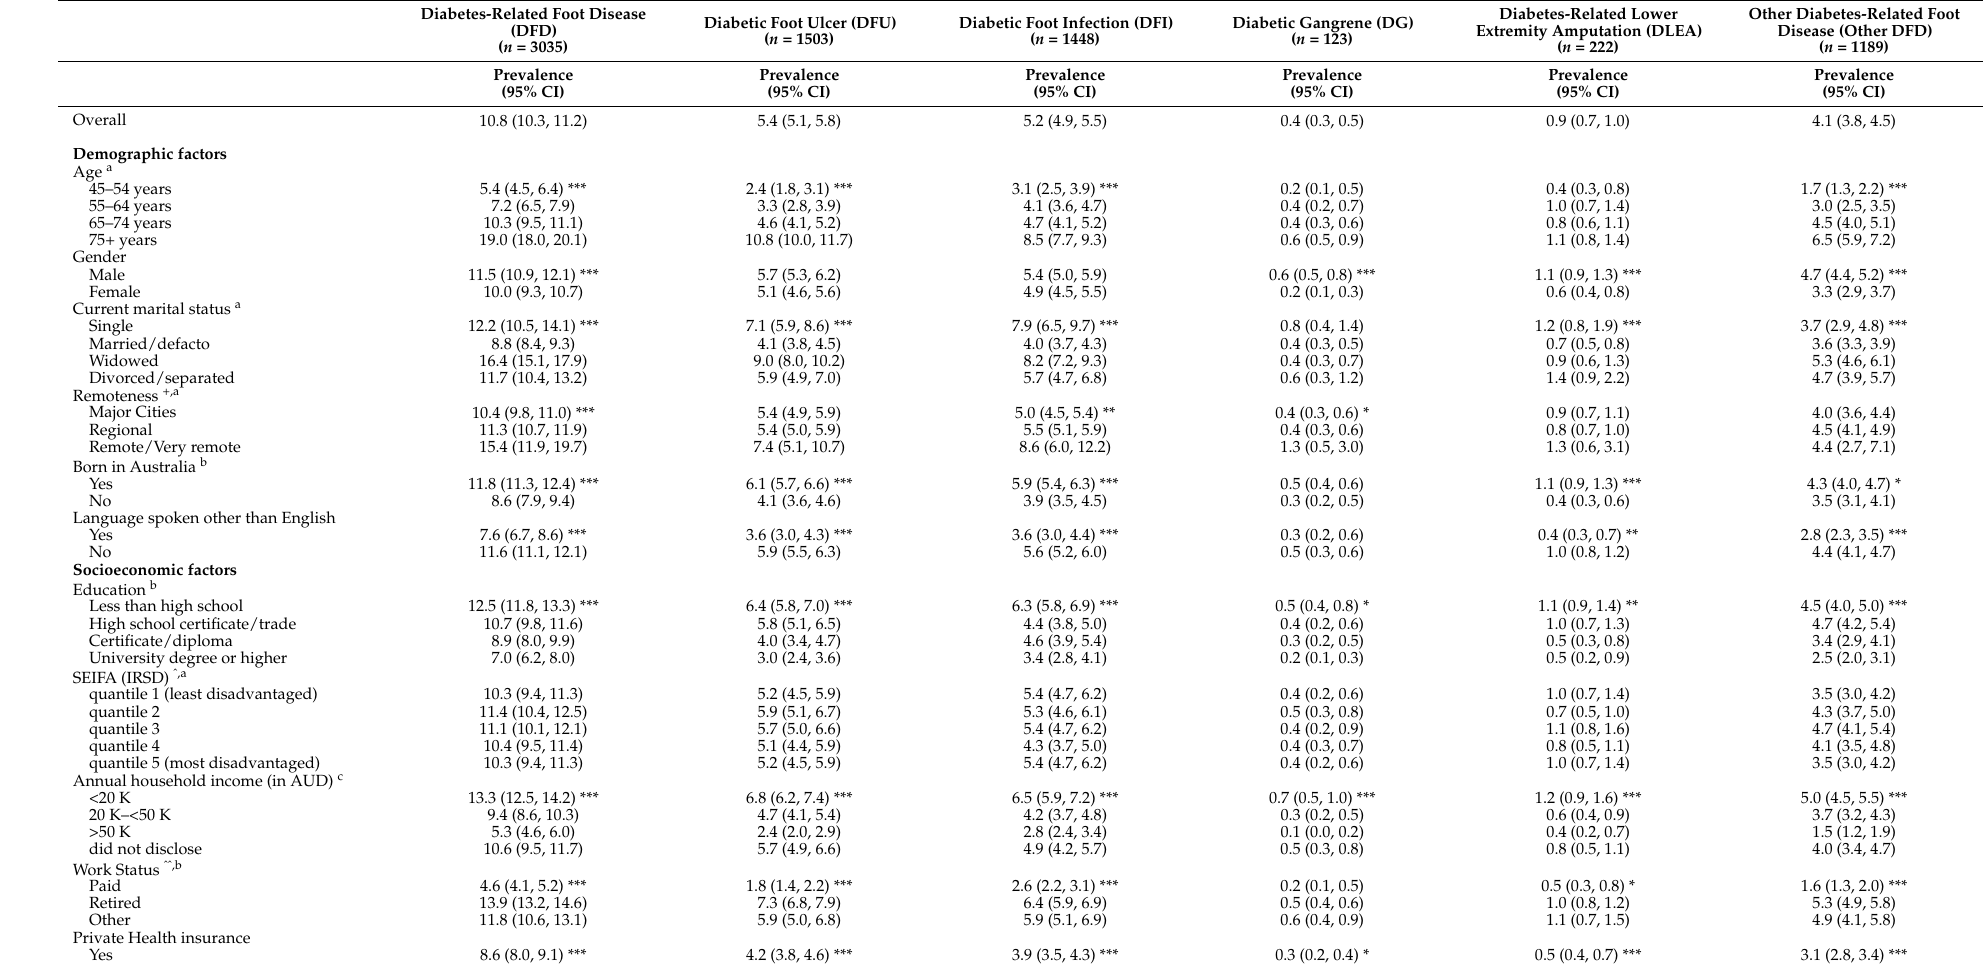
Table 2. Prevalence of DFD, DFU, DFI, DG, DLEA, and other DFD among people with diabetes in terms of demographic, socioeconomic and lifestyle risk